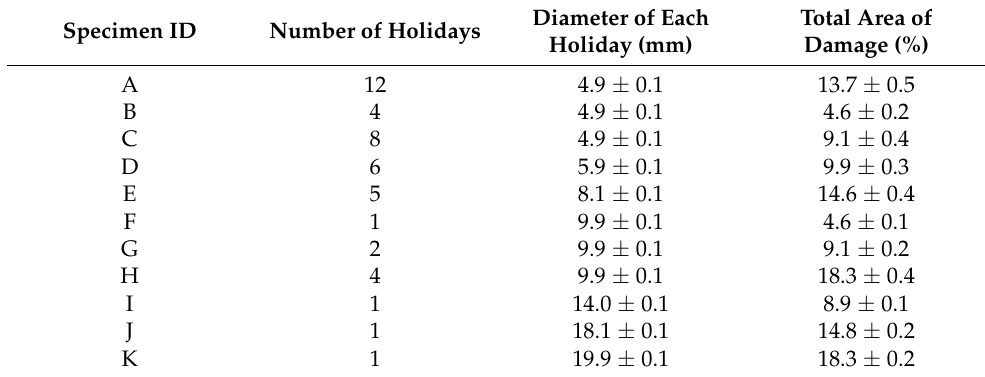
Table 3. Summary of the specimens used for testing along with the area of damage. Specimen ID